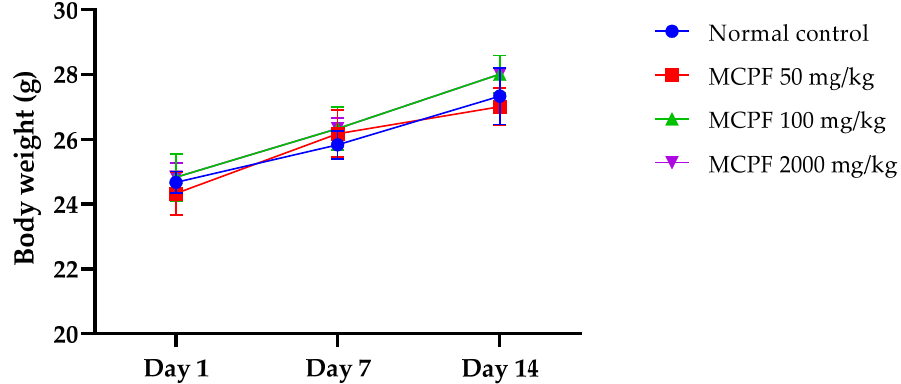
Figure 7. Bodyweight development of mice treated with a single oral administration of the PEMC.